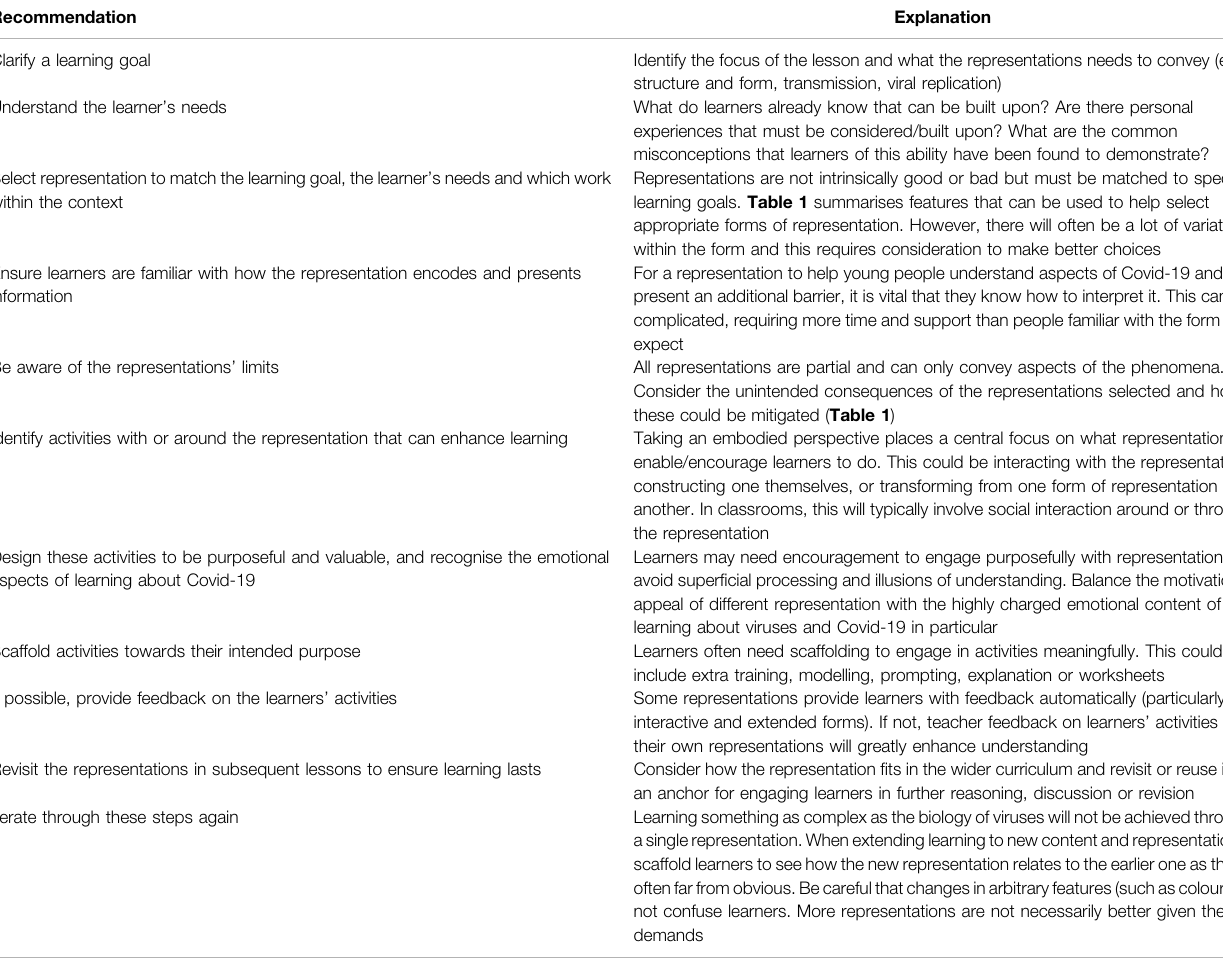
TABLE 2 | A Covid-19 representational